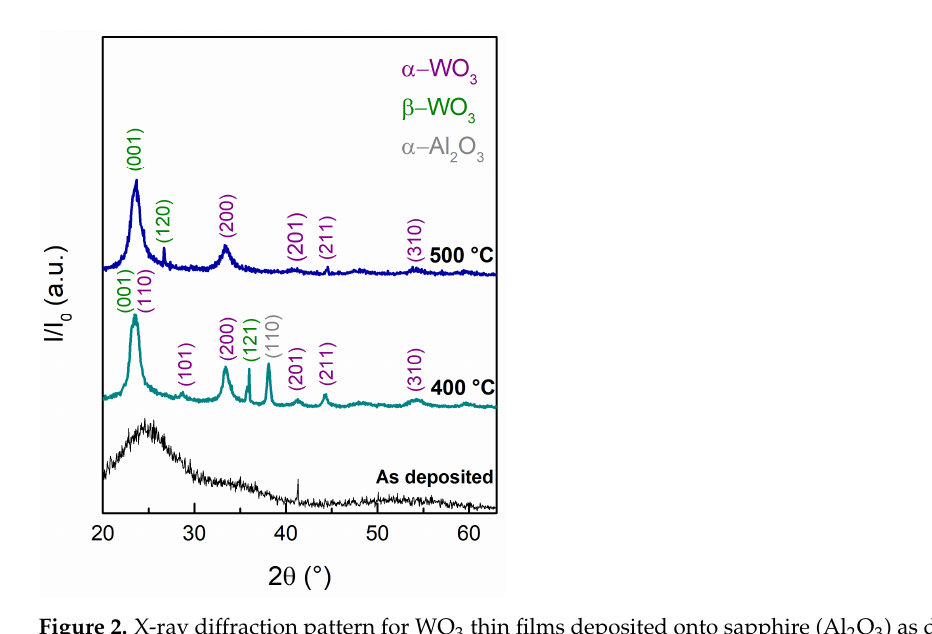
Figure 2. X-ray diffraction pattern for WO 3 thin films deposited onto sapphire (Al 2 O 3 ) as deposited and annealed at 400 ◦ C and 500 ◦ C in a 3% H 2 /N 2 forming gas environment.